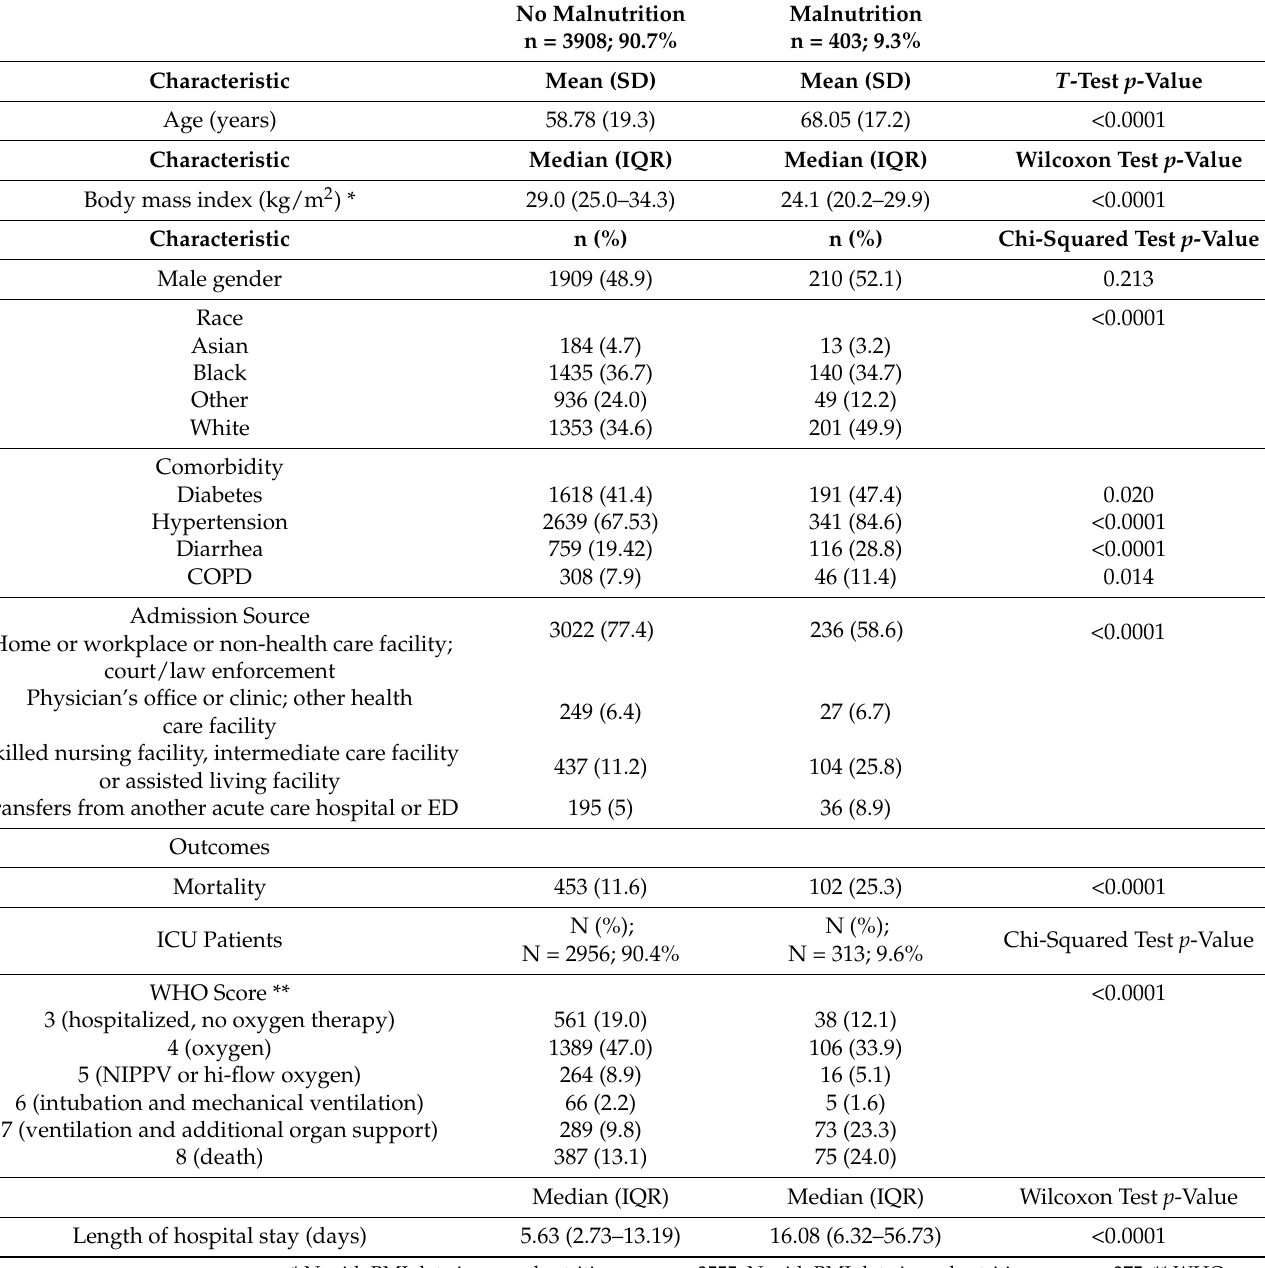
Table 1. Sample characteristics and outcomes by malnutrition status. No Malnutrition n = 3908; 90.7%